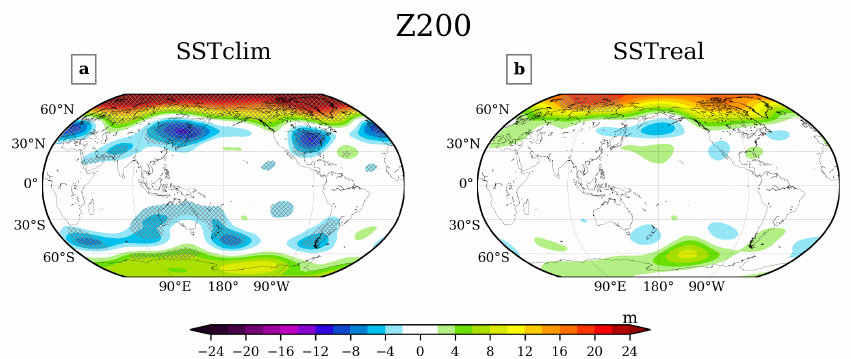
Figure 3. As in Figure 2, but for the winter 200 hPa geopotential height field. ( a ) For SSTclim case and ( b ) For SSTreal